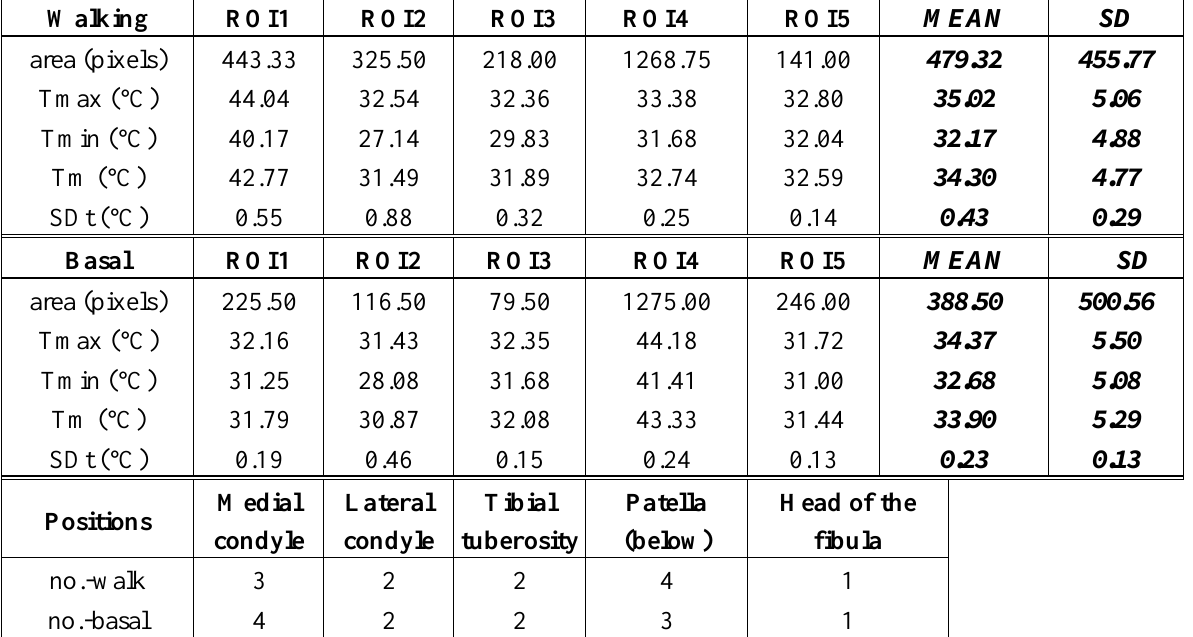
Table 5. Hot spots and related inter-subjective average